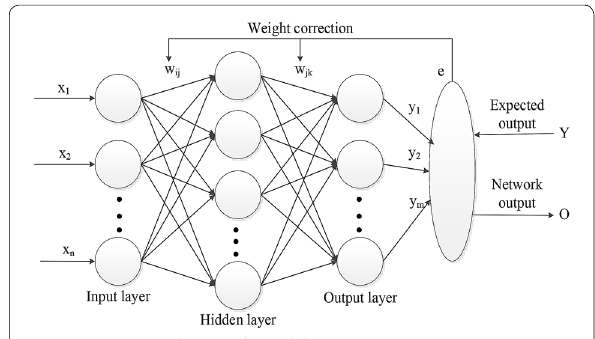
Figure 7 BP neural network model